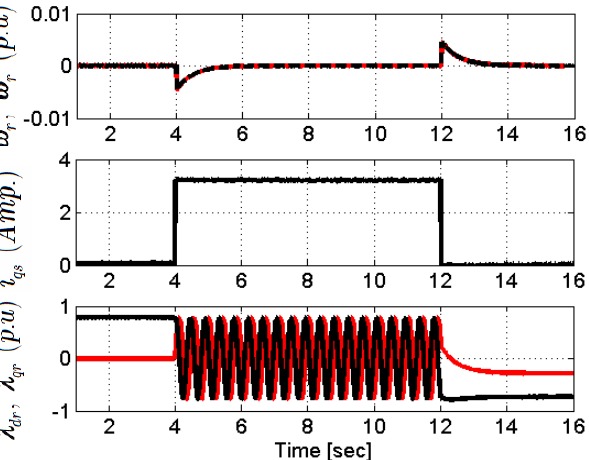
Figure 19. Simulation tests at speed reference of 0 p.u (0 rd/s) with rated load torque change of +7 N.m applied at t = 4 s and removed at t = 12 s.